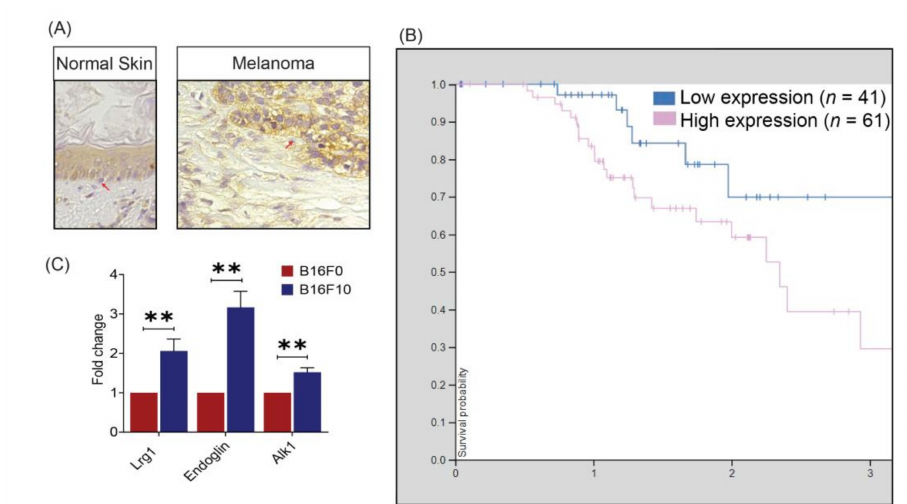
Figure 1. LRG1 expression in human melanoma biopsies and mouse melanoma cell lines. ( A ) Representative photomicrographs of immunohistochemistry staining demonstrating the expression pattern of LRG1 in normal human skin and malignant melanoma tissue. ( B ) Kaplan–Meier curves showing stratification of three-year survival probability as a function of LRG1 RNA expression (adapted from The Human Protein Atlas). ( C ) Real-time quantitative PCR analysis of Lrg1, endoglin , and Alk 1 expression. Data are presented as the mean ± S.E.M of three independent experiments. Statistical analysis was performed via two-tailed, unpaired Student’s t -test; ** p <